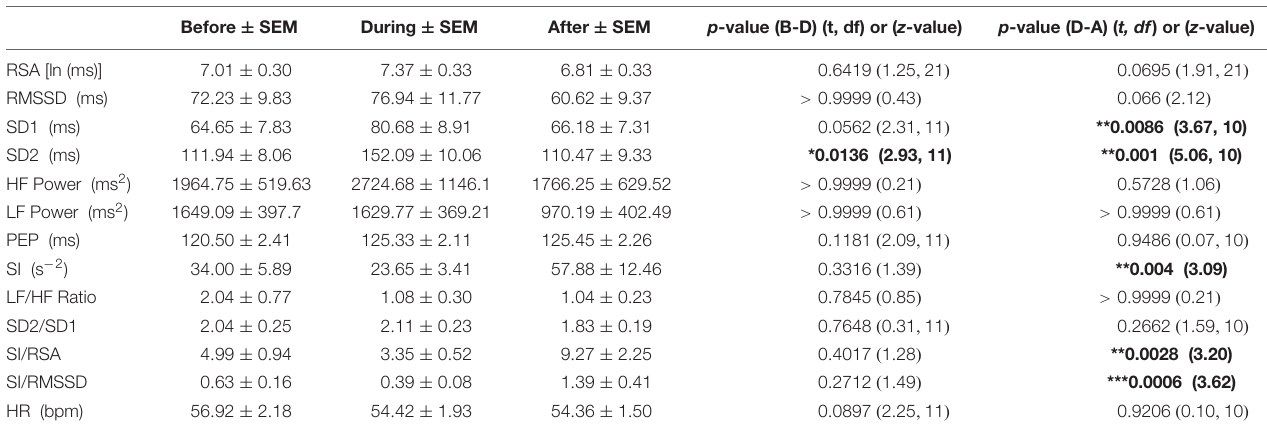
TABLE 3C | HRV parameters associated with HAPWs during baseline ( n =